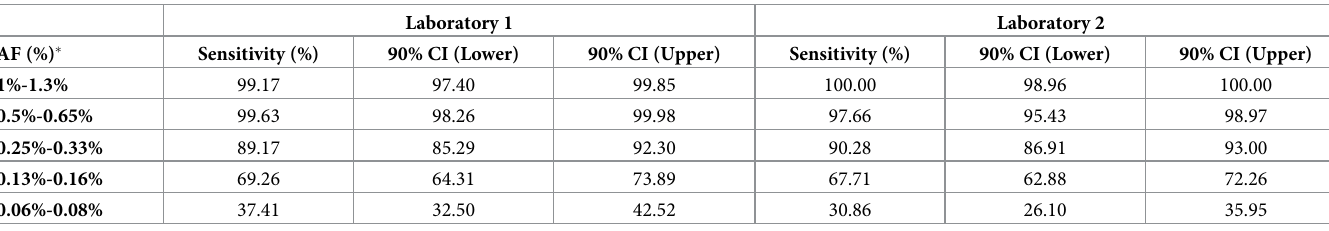
(cid:3) AF shows indicative ranges for Tru-Q reference material, full list of values presented in S4, S5 and S6